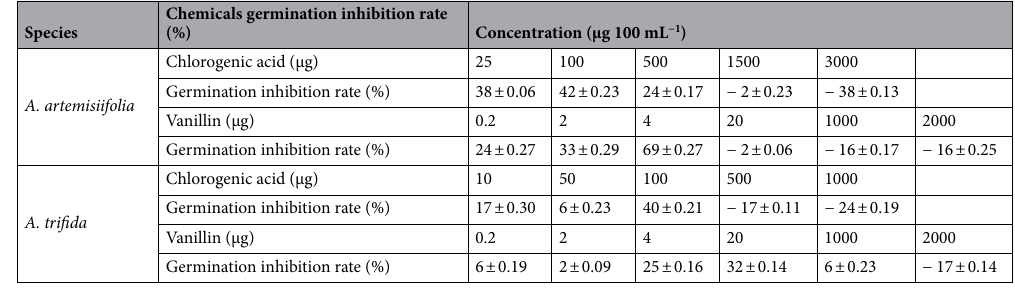
Table 2. Verification effects of chlorogenic acid and vanillin on seed germination of A. artemisiifolia and A. trifida ( M ± SD ). Positive value of germination inhibition rate (%) means promoting germination, negative value means inhibiting